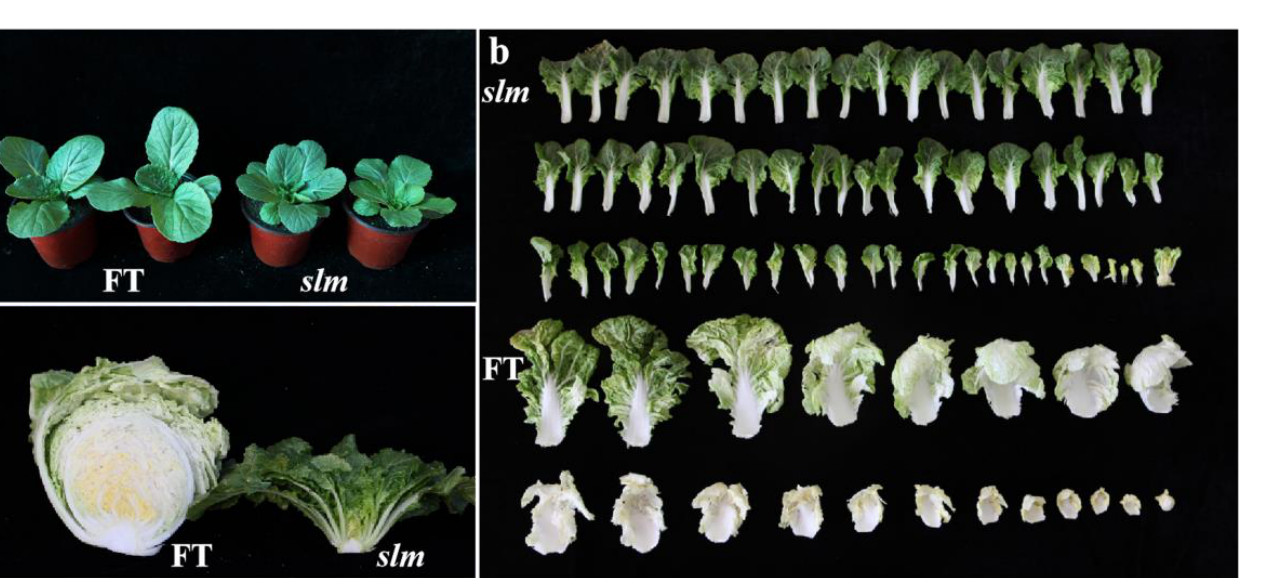
Figure 1. The phenotype characteristics of FT and slm . ( a ) The phenotype characteristics of FT and slm at seedling stage. ( b ) Longitudinal anatomical drawing in leafy head of FT and slm . ( c ) Split diagram of leafy head in slm and FT.